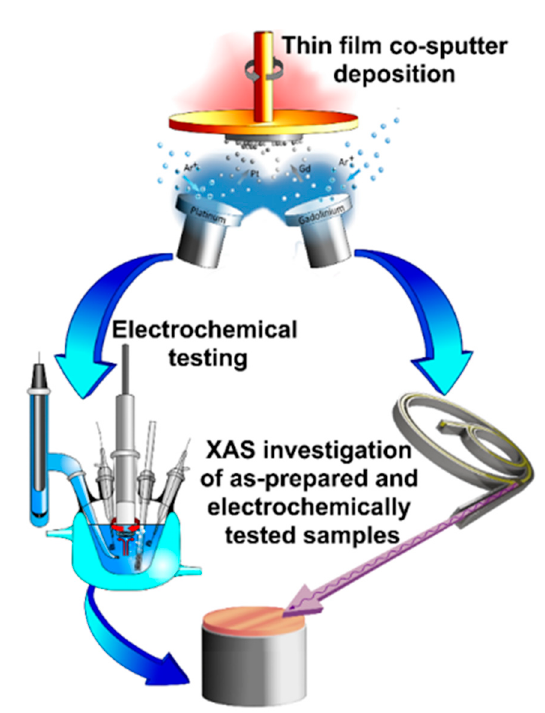
Figure 1. Illustration of the experimental methods carried out to investigate 10-nm Pt x Gd thin films.